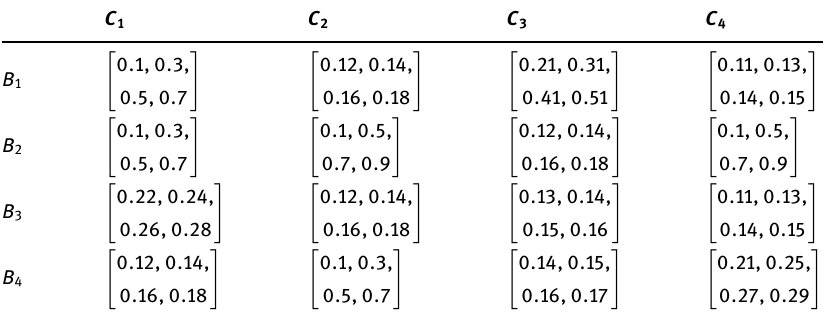
Table 11: Trapezoidal Fuzzy Decision Matrix.